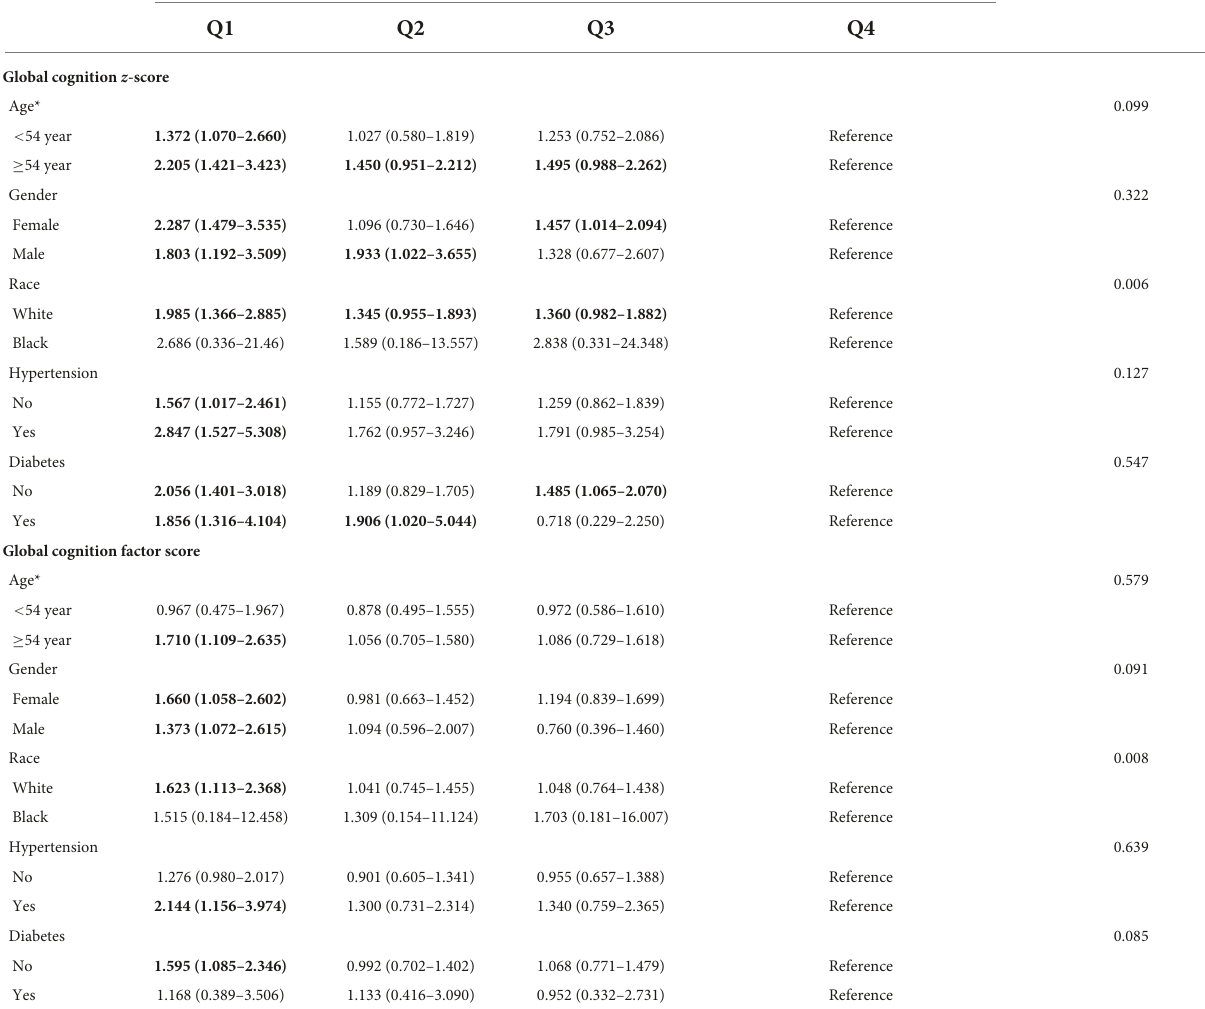
TABLE 4 Adjusted ORs (95% CIs) for the association of baseline (1991–1993) cognition function with incident elevated NT-proBNP in different subgroups.